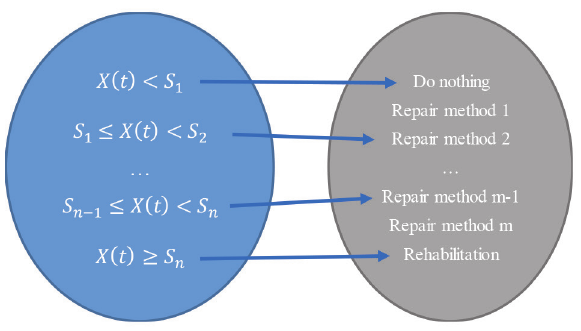
Figure 2. SOM approach with multi-levelled service state